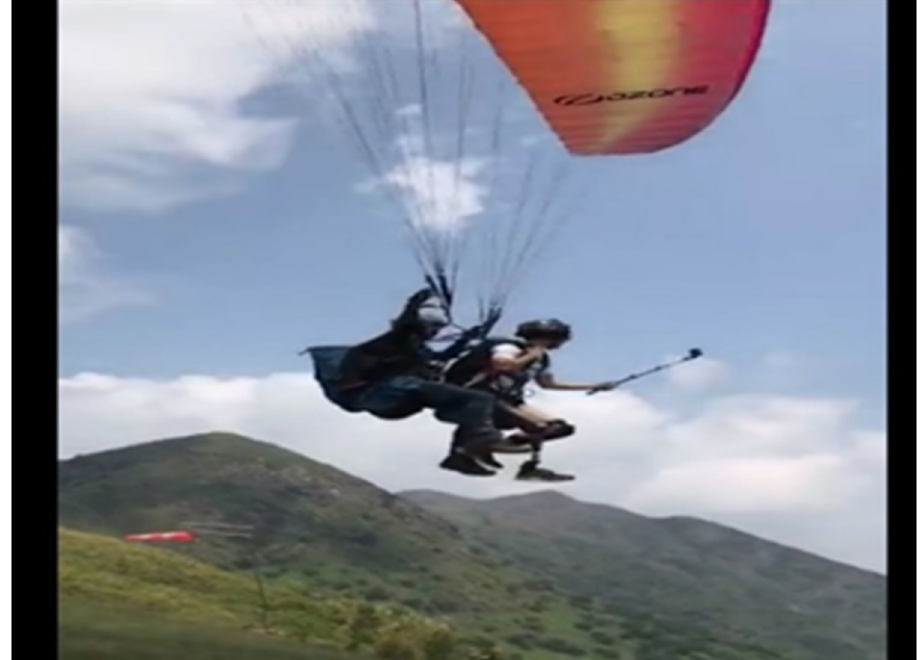
Figure 6. Photograph by Participant G.